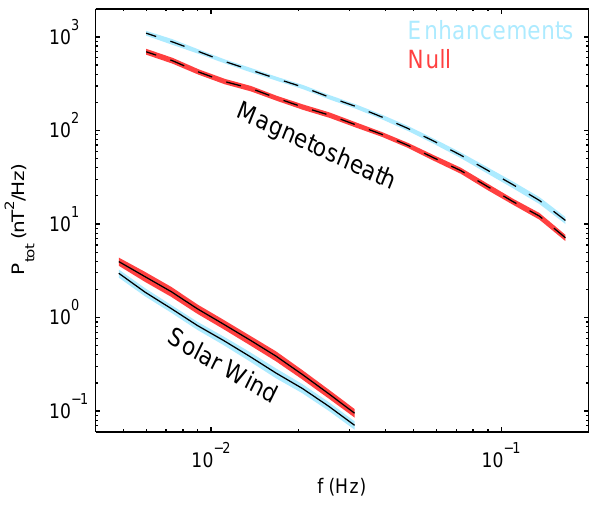
Fig. 7. Mean background superposed wavelet power spectra in the magnetosheath (dashed lines) and solar wind (solid lines) are shown, along with corresponding 95% confidence intervals (coloured regions) for both the dynamic pressure enhancements (blue) and null (red)